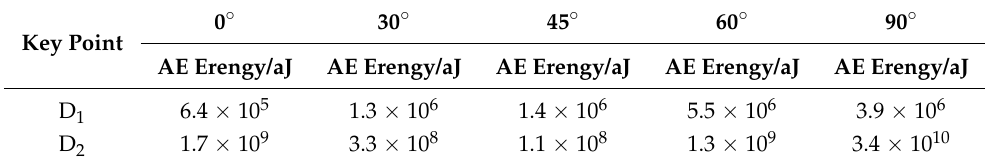
Table 7. AE energy level for different bedding angles under dry state.